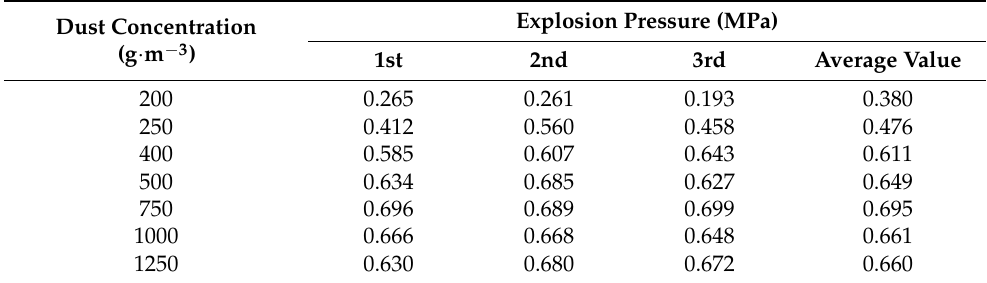
Table 2. Explosion pressure of cassavas dust under different dust concentrations. Dust